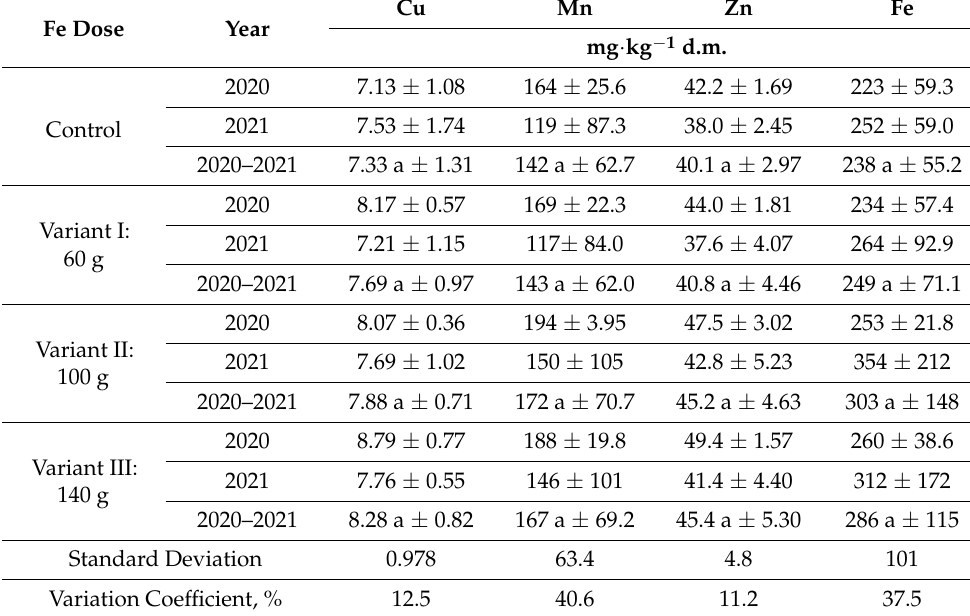
Table 6. Effect of Fe fertilization on the microelement content in plants.